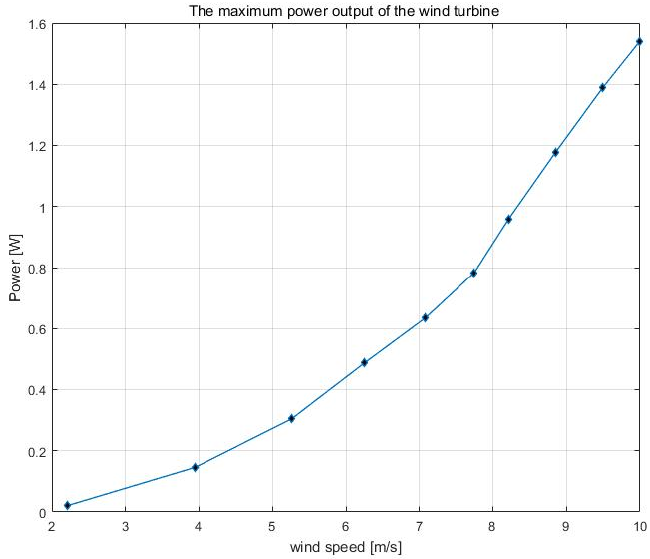
Figure 12. The maximum power of a wind turbine.